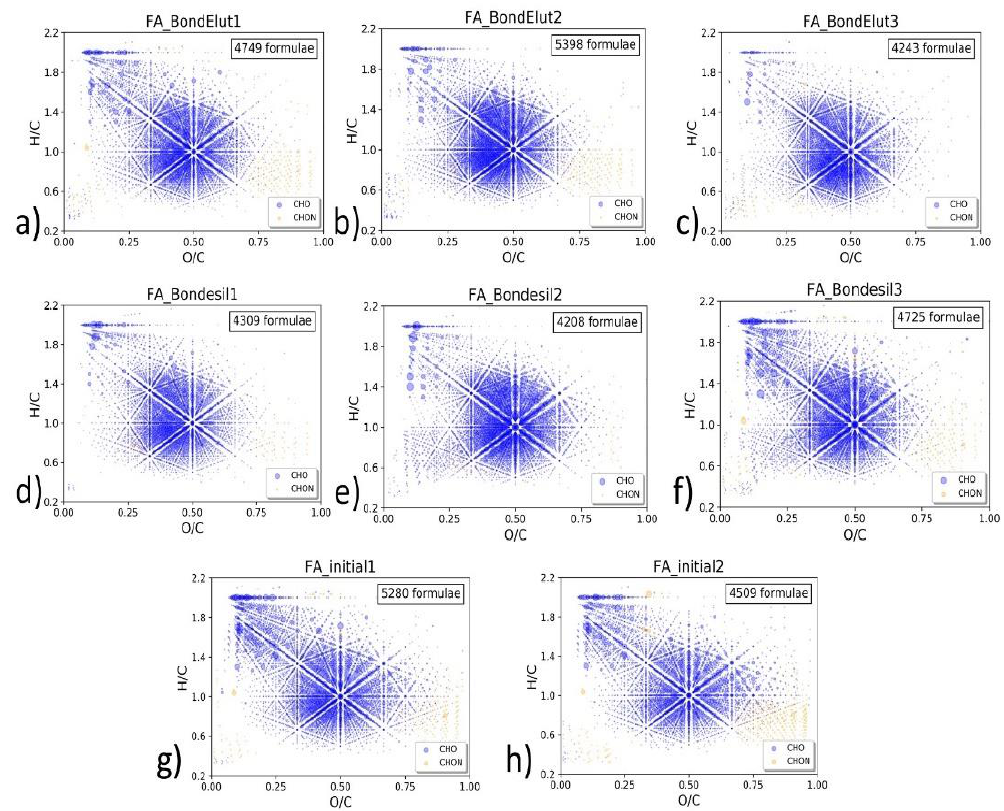
Figure 3. Van Krevelen plots for the three FA-BE samples ( a – c ), for the three FA_BS samples ( d – f ), and for the two spectra of the parent FA ( g , h ). The dot size corresponds to the peak intensity in the mass list. CHO formulae are highlighted in blue, and CHON—in yellow. The number of assigned formulae for the sample is displayed in the upper right corner.